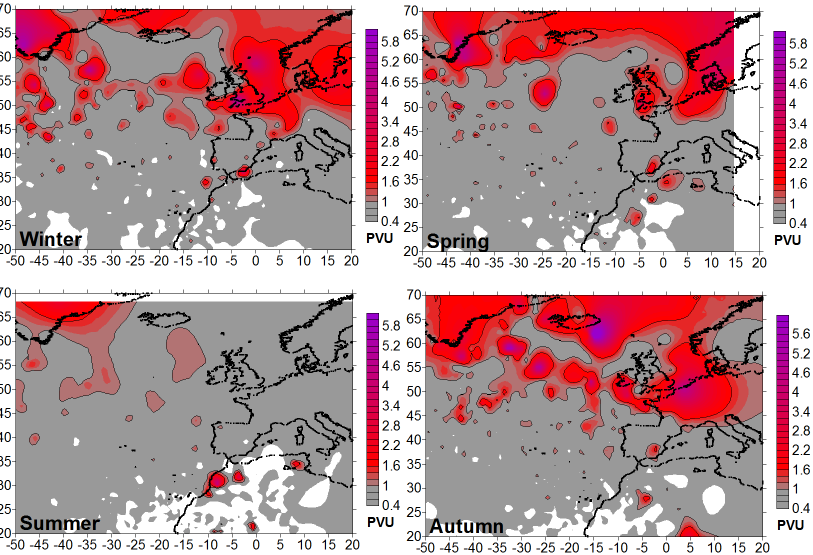
Fig. 10. PV max maps for winter (JFM), spring (AMJ), summer (JAS) and autumn (OND) in the period 1988–2009. They have been con- structed from the coordinates of PV max values found by 5-day backward trajectories arriving at IZO every day at 00:00UTC in ECMWF Fig. 10. PV maps for winter (JFM), spring (AMJ), summer max PV-reanalysis fields. Thresholds of 1 and 1.6PVU are marked with black lines.